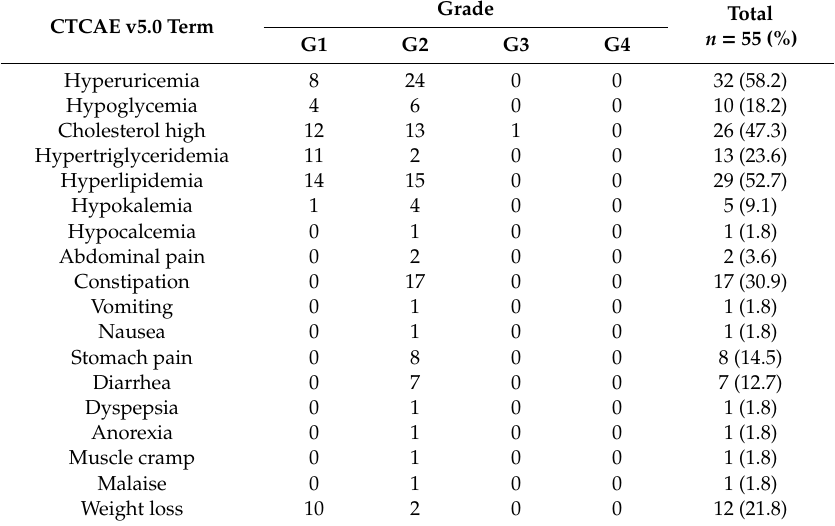
Table 2. Summary of adverse events from enrollment to 3